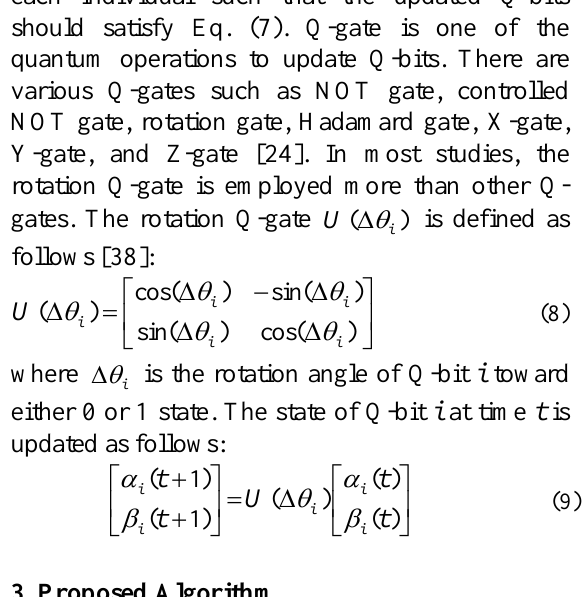
Figure 1. Pseudo-code of ABC algorithm.